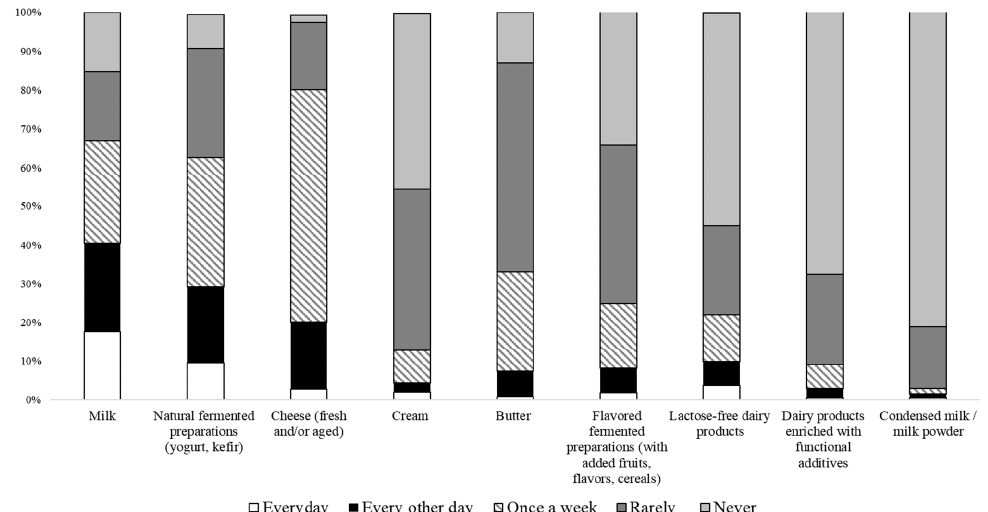
Figure 2. Frequency of purchase of different dairy products.